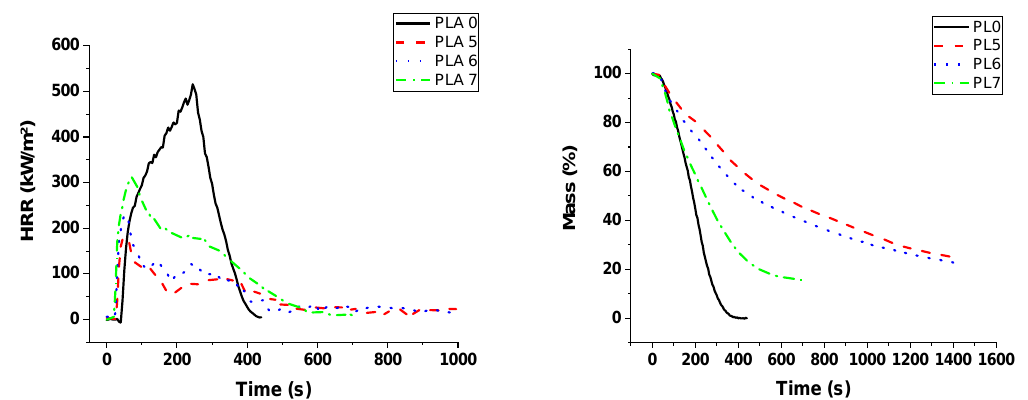
Figure 16. Heat release rate and mass for PLA/APP/lignin composites from cone calorimeter. Table 7. Cone calorimeter results for PUE and PLA/APP/lignin composites.